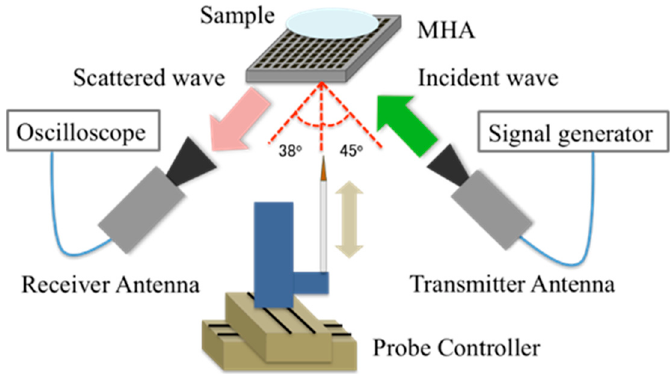
Figure 10. The experimental system for one- and two- dimensional imaging experiments.